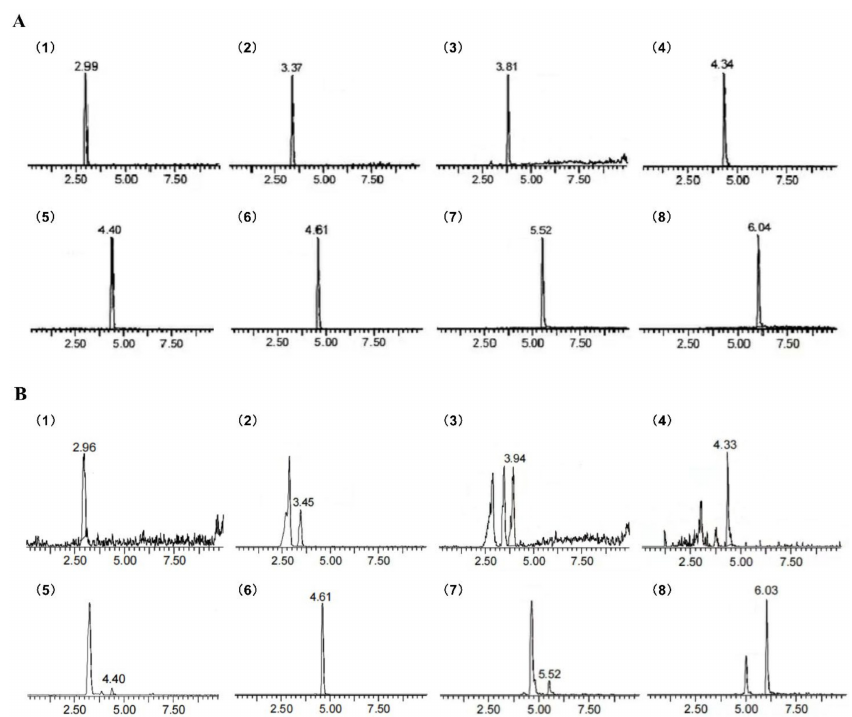
Figure 2. MRM chromatogram of Hemerocallis citrina Baroni. phenolic compounds (HCP) showing the presence of eight phenolic compounds as identified. ( A ) MRM chromatogram of standards; ( B ) MRM chromatogram of HCP. Peaks: (1) protocatechin, (2) chlorogenic acid, (3) caffeic acid, (4) taxifolin, (5) gentisic acid, (6) rutin, (7) quercetin, (8)